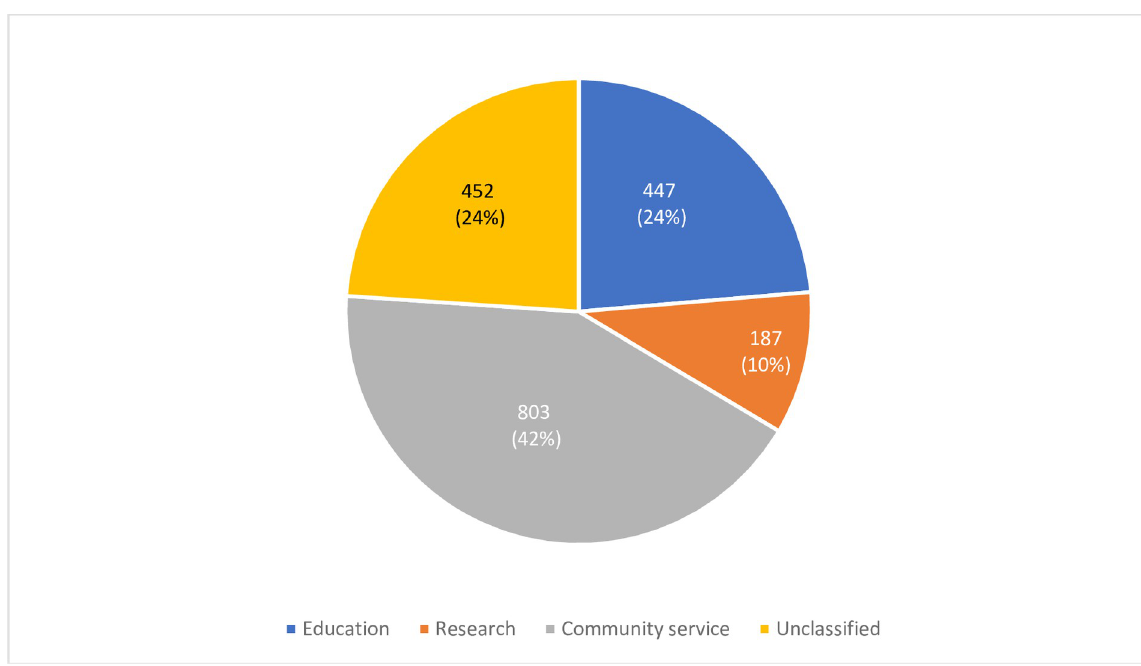
Fig 4. Distribution of tweets per academic role for all dental schools.